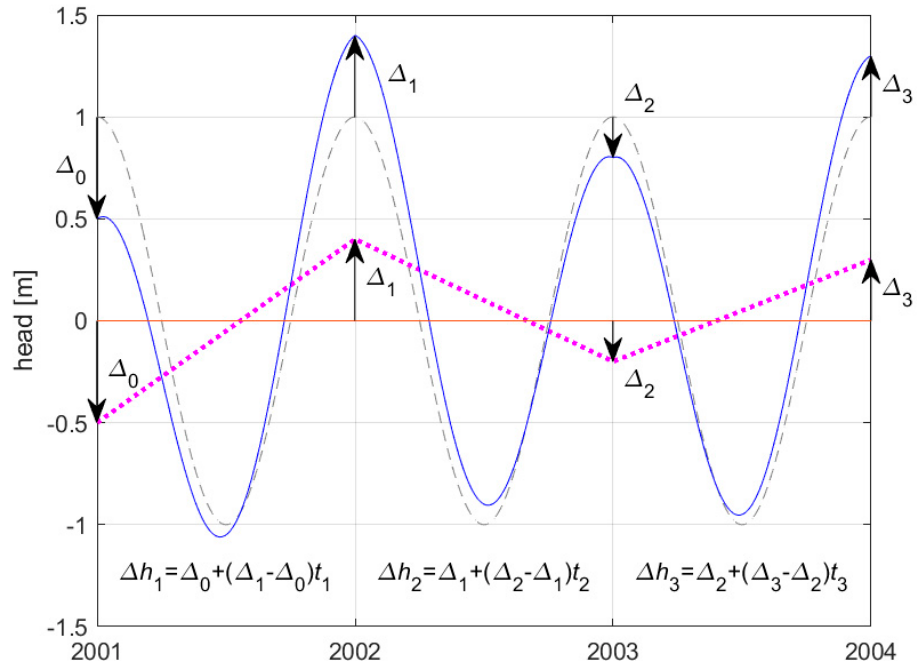
Figure 3. Schematic of the precipitation adjustment Δ h in Equation (3).